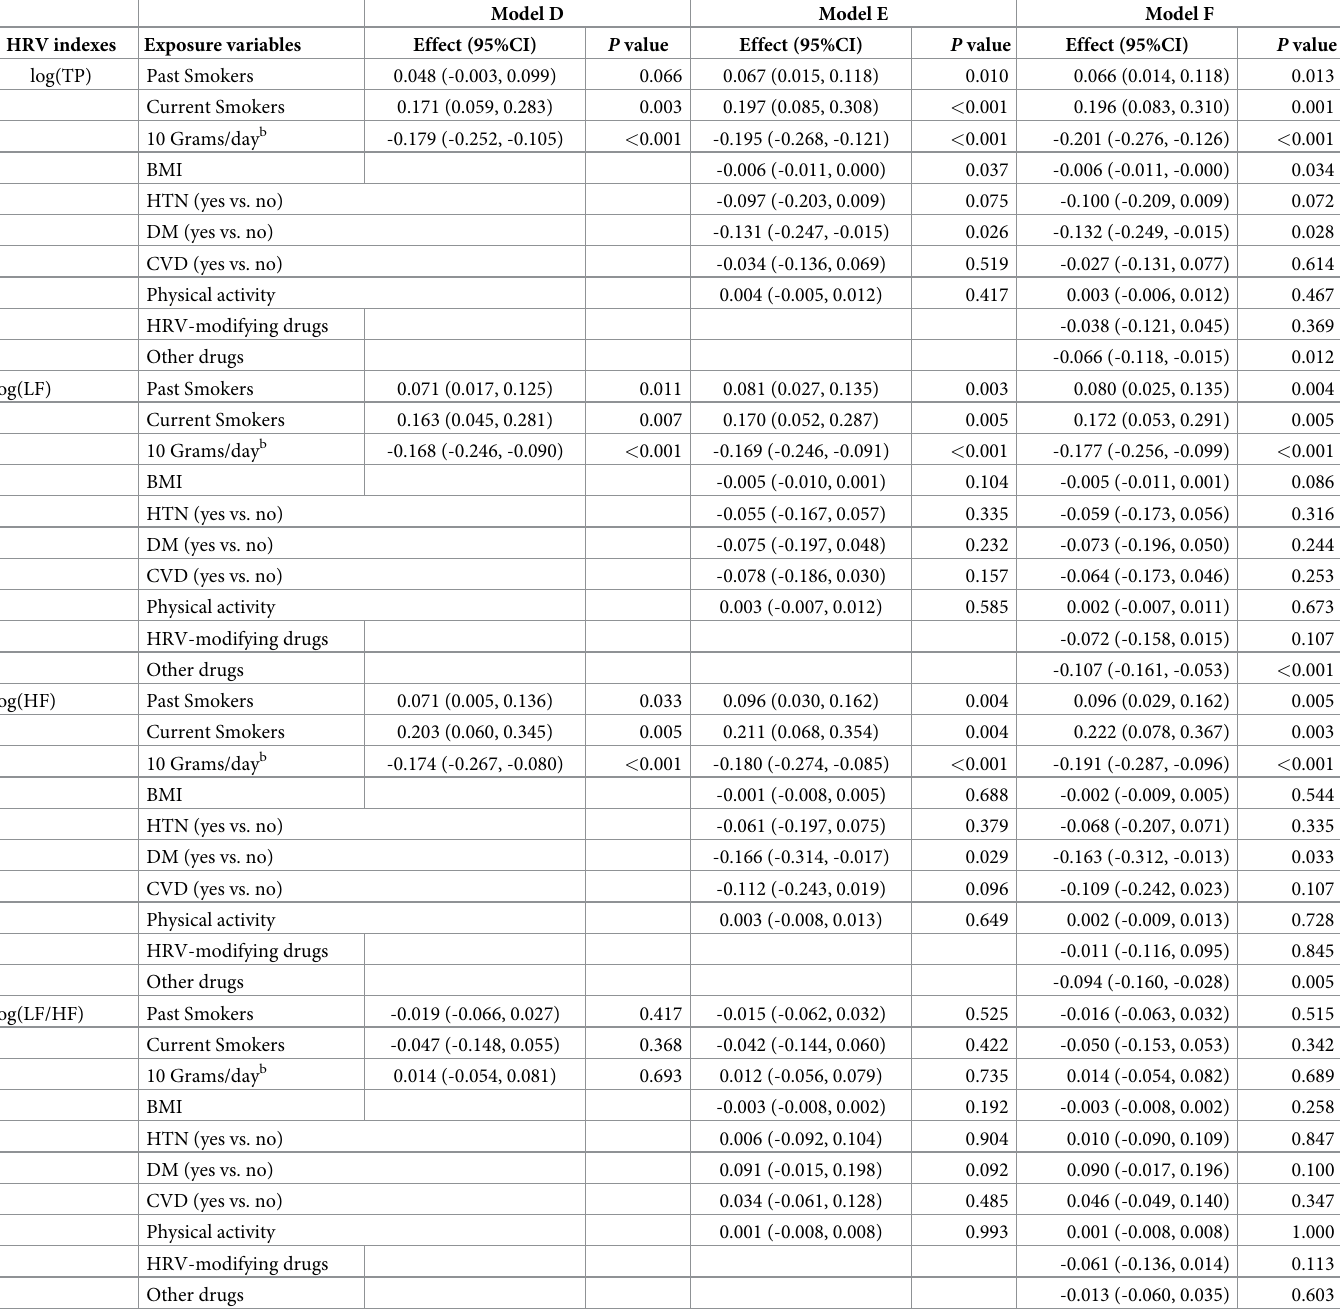
Table 5. Association of HRV frequency-domain indexes with smoking status and intensity (model D); smoking status, smoking intensity and cardiometabolic risk factors (model E); and smoking status, smoking intensity, cardiometabolic risk factors, and drugs (model F) a